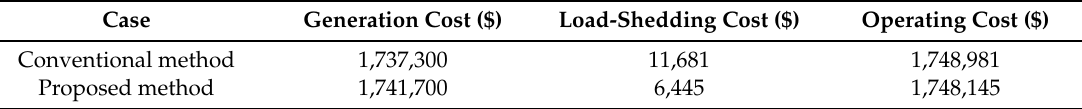
Table 4. The calculated costs for the conventional method and the proposed method.